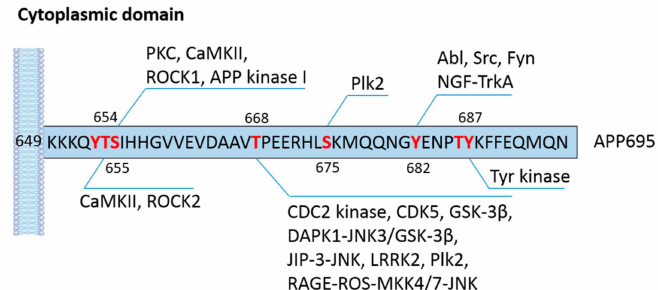
Figure 2. Phosphorylation sites of APP695 in the cytoplasmic domain and the reported kinases / signaling pathways. Eight phosphorylation sites (marked in red) have been reported in the cytoplasmic domain of APP695. Kinases and signaling pathways that are able to phosphorylate these amino acid residues according to the literature are summarized in the scheme. See Table 1 for full list of